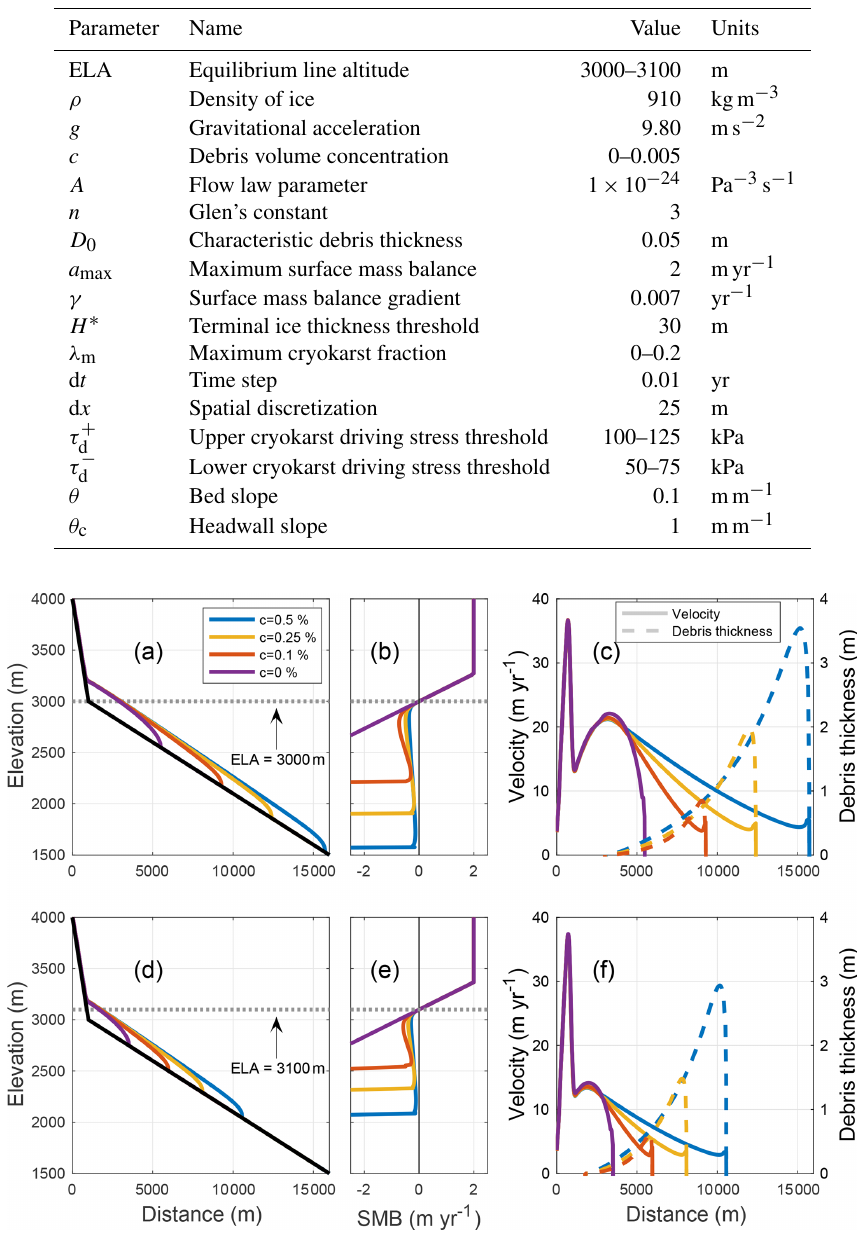
Figure 2. Steady-state glacier geometry profiles (a, c) , and profiles of surface velocity (solid lines) and debris thickness (dashed lines) (b, d) , corresponding to ELA = 3000 and 3100m for four different debris